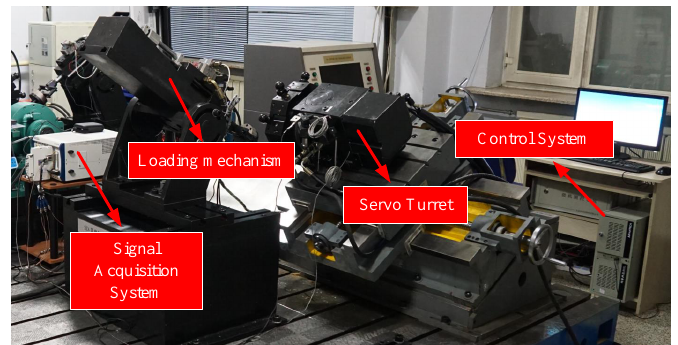
Figure 2. Reliability test system of the servo turret.